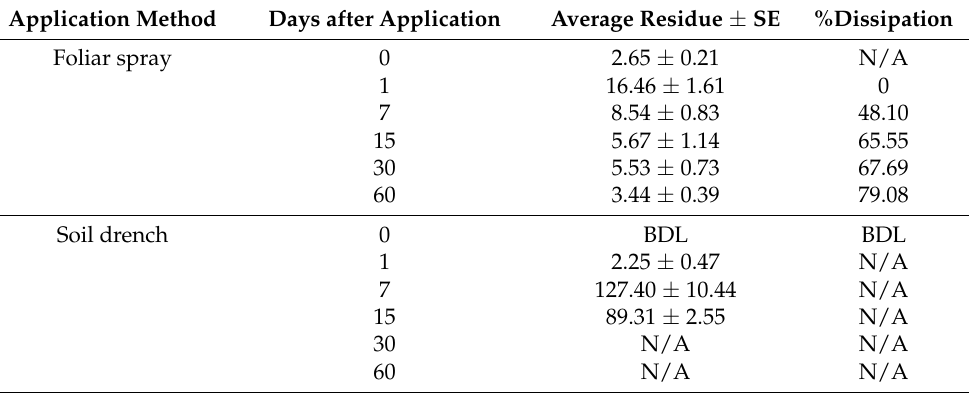
Figure 5. Metalaxyl concentrations in durian leaf after spraying at the concentration of 4 g/L foliar spraying ( A ) and soil drenching ( B ). Because durian seedlings treated with drenching died within 15 days, data collection was discontinued. Each bar represented the standard error of means (SEM) from nine replications at a significant level of 0.05 using ANOVA followed by Duncan’s multiple range test. Two independent experiments were performed. Table 3. Average recovered concentrations of metalaxyl in durian leaf for repeatability and repro- ducibility determination.